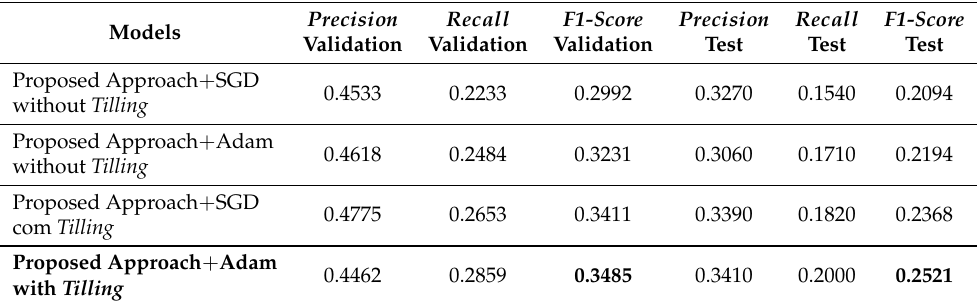
Table 8. Results obtained with the metrics: Precision , Recall and F1- score with the Stochastic Gradient Descent (SGD) and Adam optimizers during the validation and testing steps using the Dataset for Diabetic Retinopathy